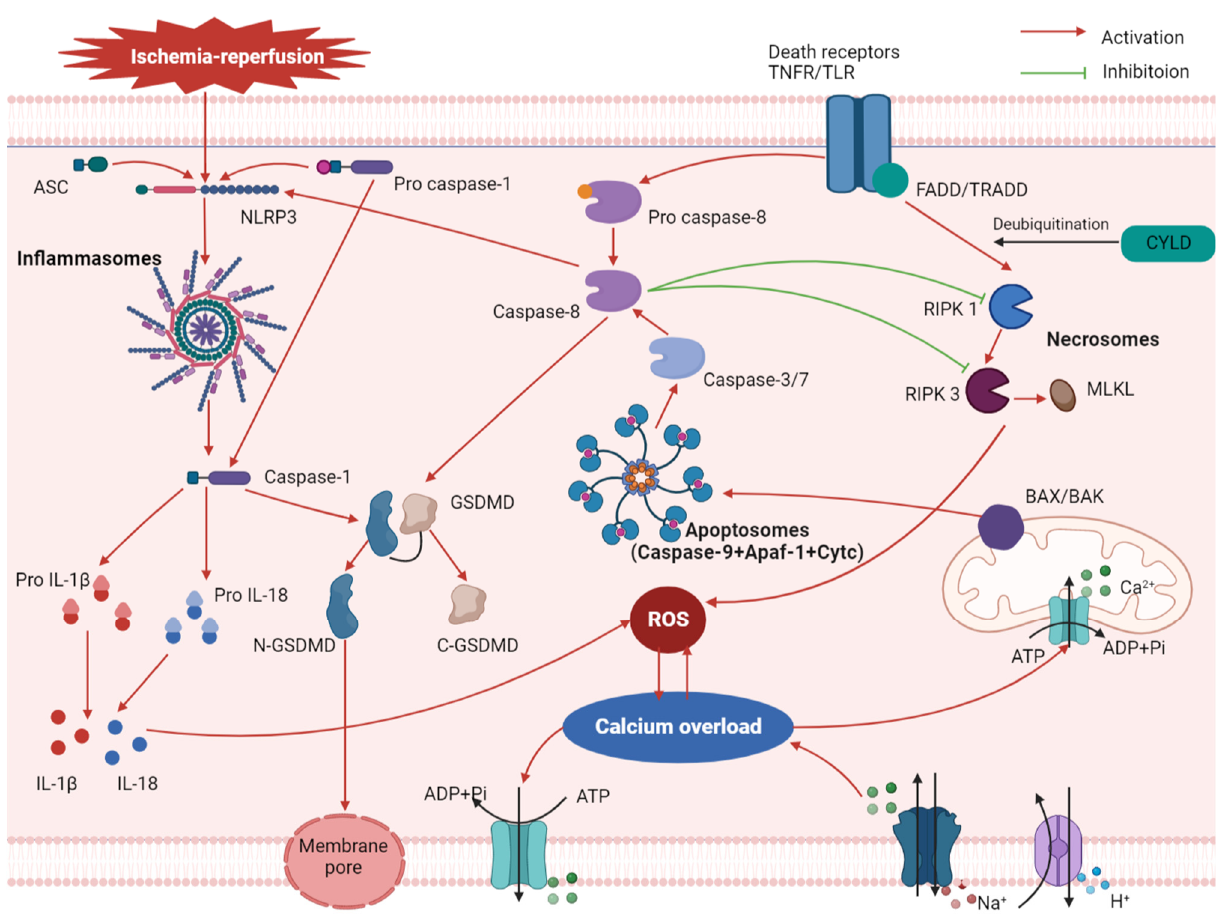
Figure 1. The cross-link between pyroptosis and other mechanisms (oxidative stress, calcium over- load, apoptosis, and necroptosis) in myocardial ischemia-reperfusion injury. 4. Effect of Pyroptosis on Non-Cardiomyocytes and Its Role in